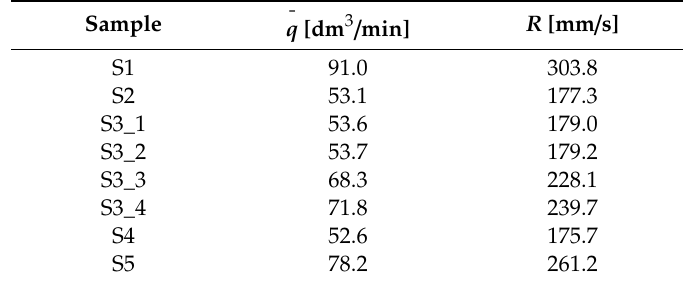
Table 3. Average values of airflow through the fabric ( q ) and air permeability ( R ) of the studied samples.